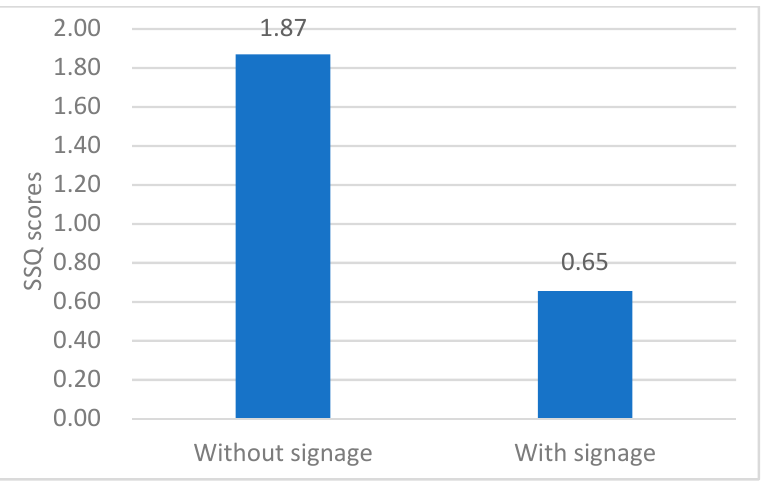
Figure 9. SSQ scores of groups without and with signage.